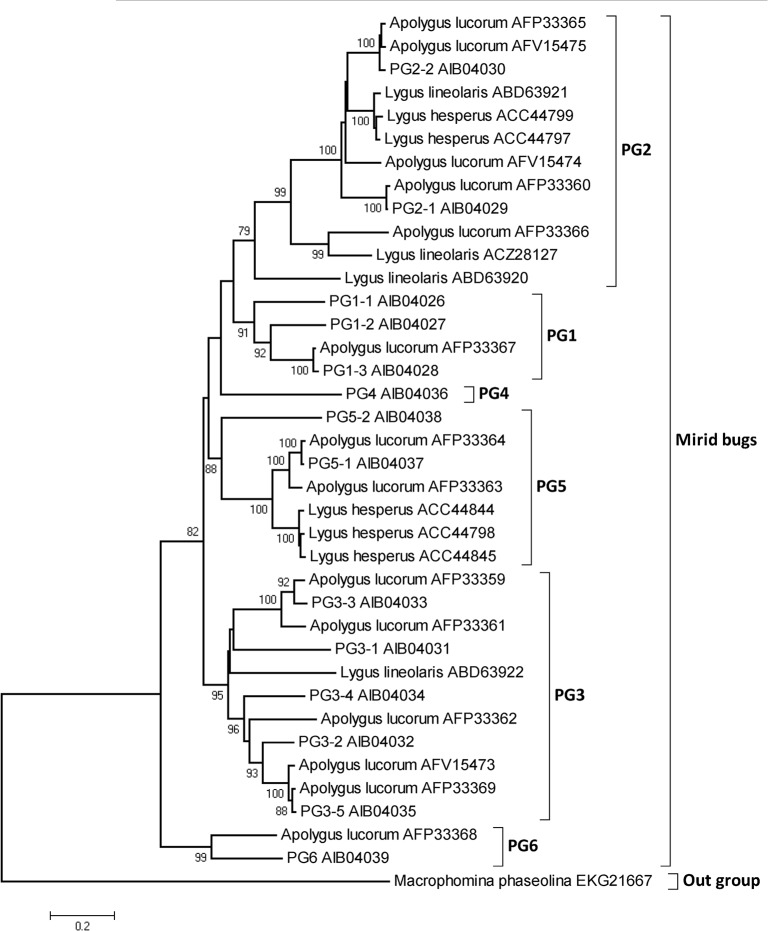
Phylogenetic analysis of PG transcritps.A neighbor-joining tree using Poisson-correction distances was constructed with PG amino acid sequences from three mirid bugs, with a glycoside hydrolase from Macrophomina phaseolina MS6 as an outgroup. Bootstrap values (1000 replicates) are indicated on the nodes, and those lower than 75 are not shown. The abbreviations represent the PGs from Apolygus lucorum identified in this study. PGs identified previously are indicated by the full Apolygus lucorum name and the associated accession number.